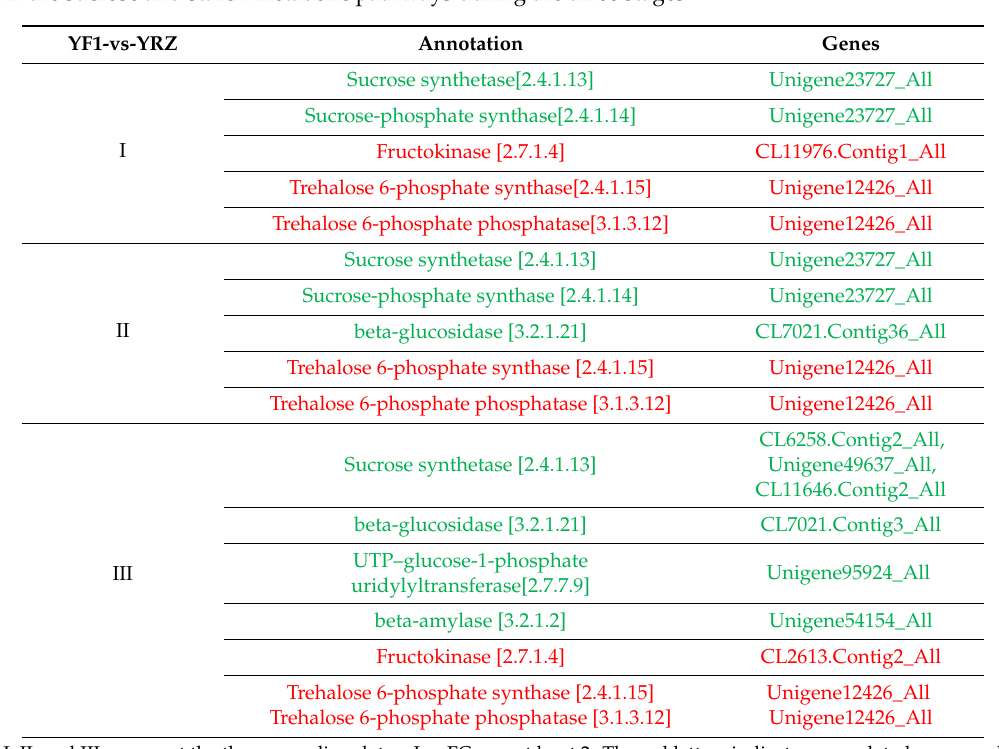
Table 4. The sucrose synthase and starch synthase genes of Yongfeng 1 (YF1) and Yongren Zao (YRZ) in the sucrose and starch metabolic pathways during the three